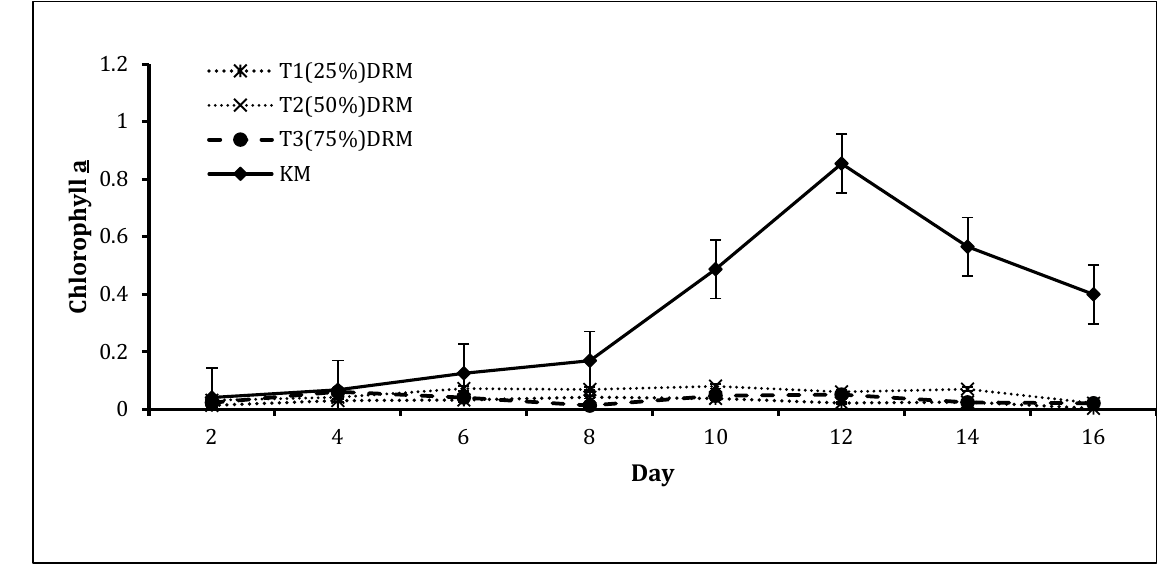
Figure 3: Mean values of chlorophyll a (mg/L) of S. platensis grown in supernatant of three different digested rotten mangoes, and Kosaric medium. Vertical bars represent standard errors.